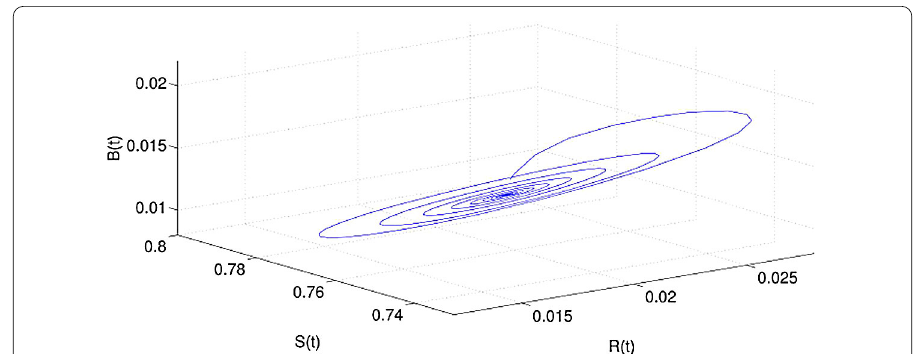
Figure 1 Dynamic behavior of system (41): projection on S-B-R with τ 1 = 4.3762